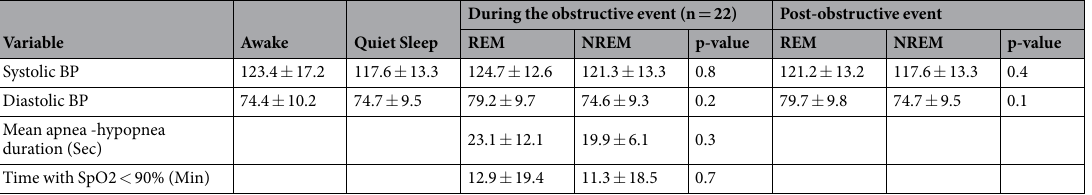
Table 4. Comparison of blood pressure during obstructive and post-obstructive respiratory events between REM and NREM sleep in patients without hypertension (n = 22).